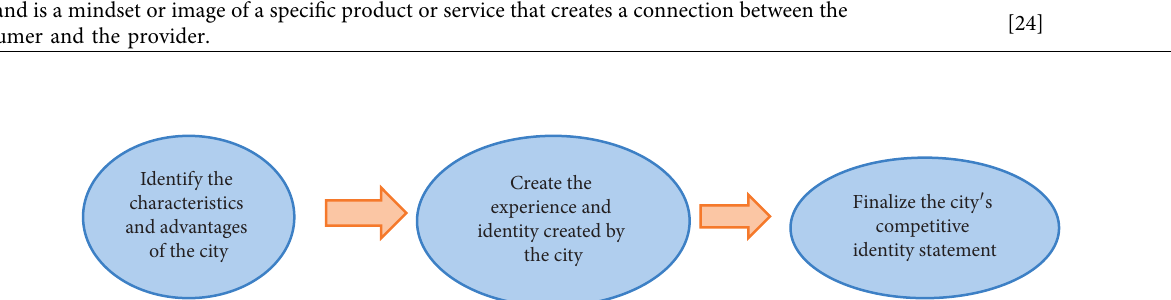
Figure 1: Organic and strategic approaches of city branding.